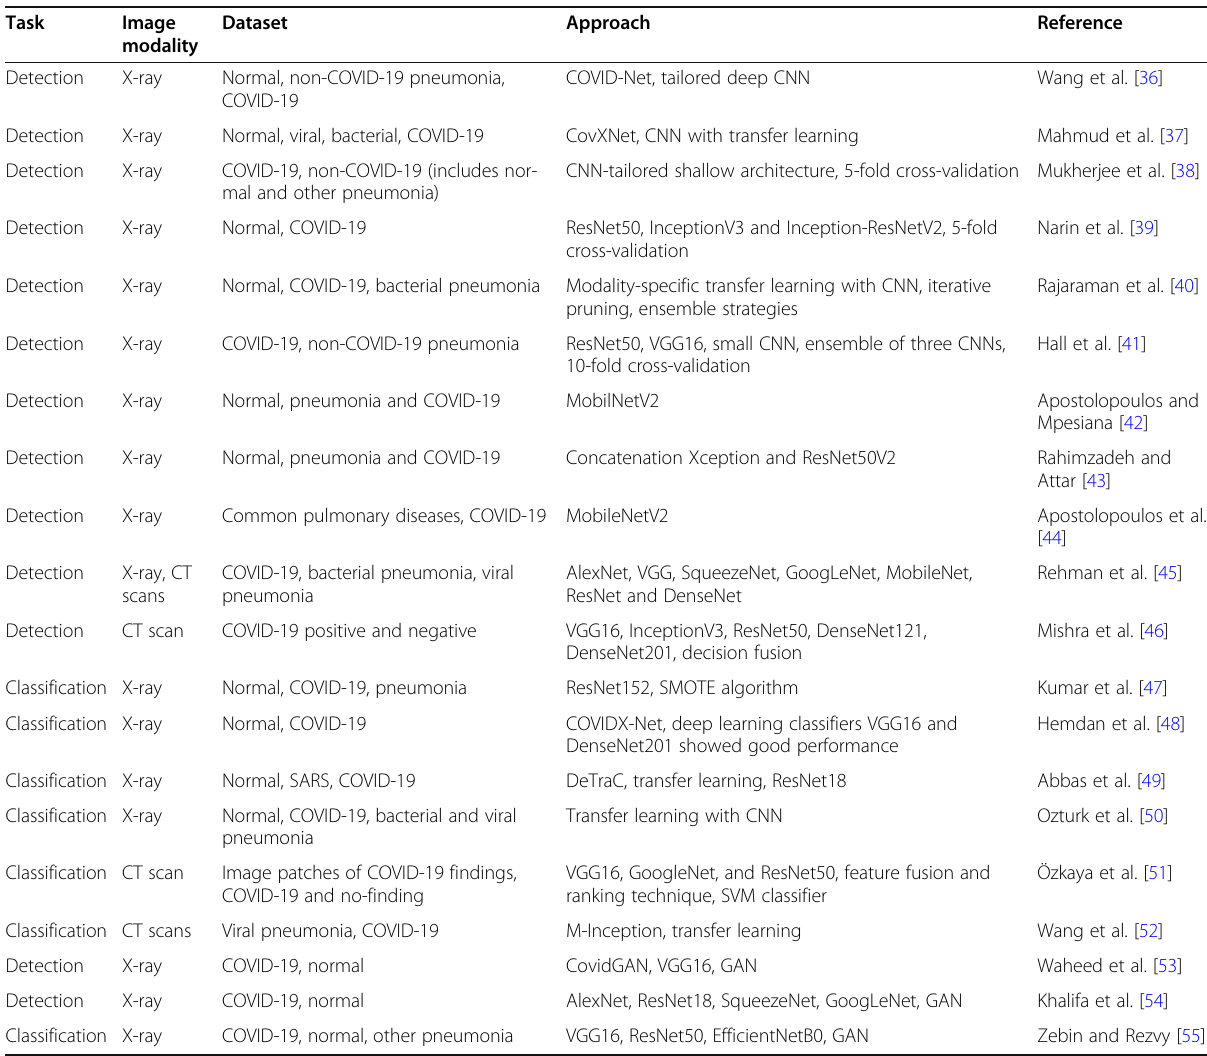
Table 2 List of CNNs used for the detection and classification of COVID-19